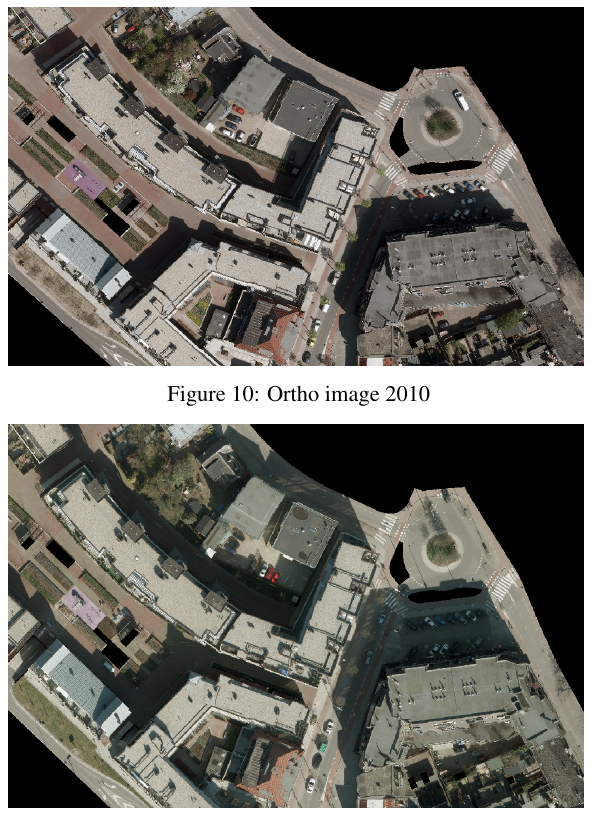
Figure 11: Ortho image 2011